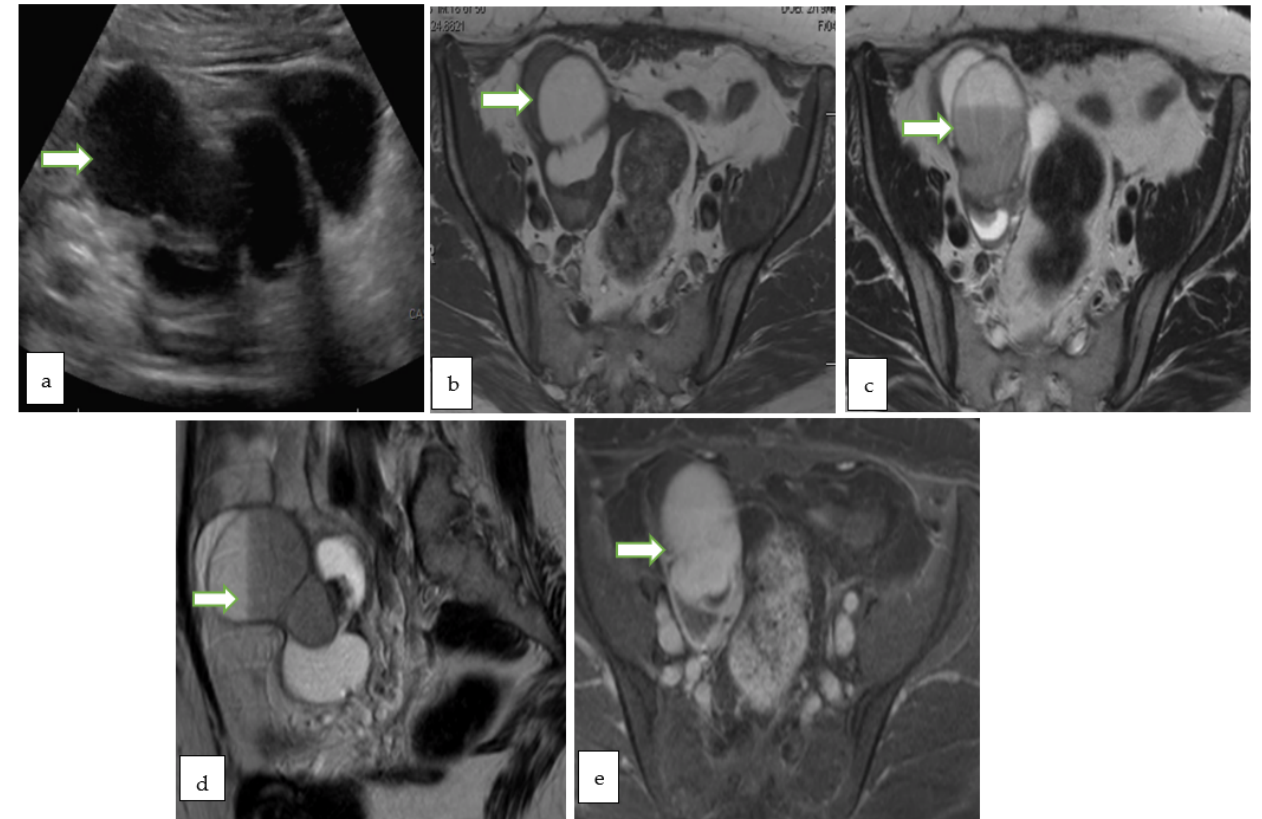
Figure 8. Gray scale US image ( a ) through the pelvis of a 42 year lady with non specific pelvic pain, shows a multiloculated right ovariancystic lesion with internal septations as well as low levels internal echoes (O-RADS category 3). Axial T1 W ( b ), Axial T2W ( c ), coronal T2W ( d ) and Axial T1 FS post contrast ( e ) MR images of the same case show a multiloculated cystic right adnexal lesion without enhancing soft tissue components or thick septations. The lesion demonstrates T1 hyperintense component with fluid-fluid level consistent with hemorrhagic/proteinaceous contents (O-RADS MRI 3).